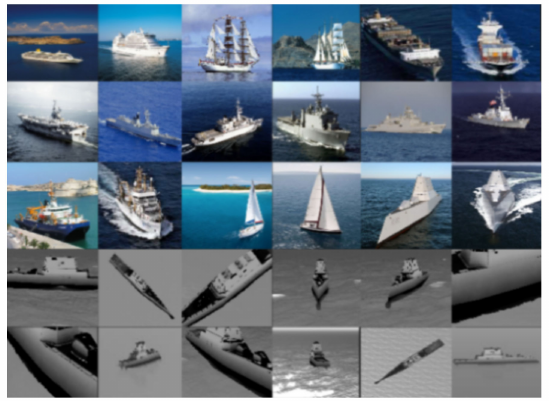
Figure 10. Sample images from the mixed-scene ship